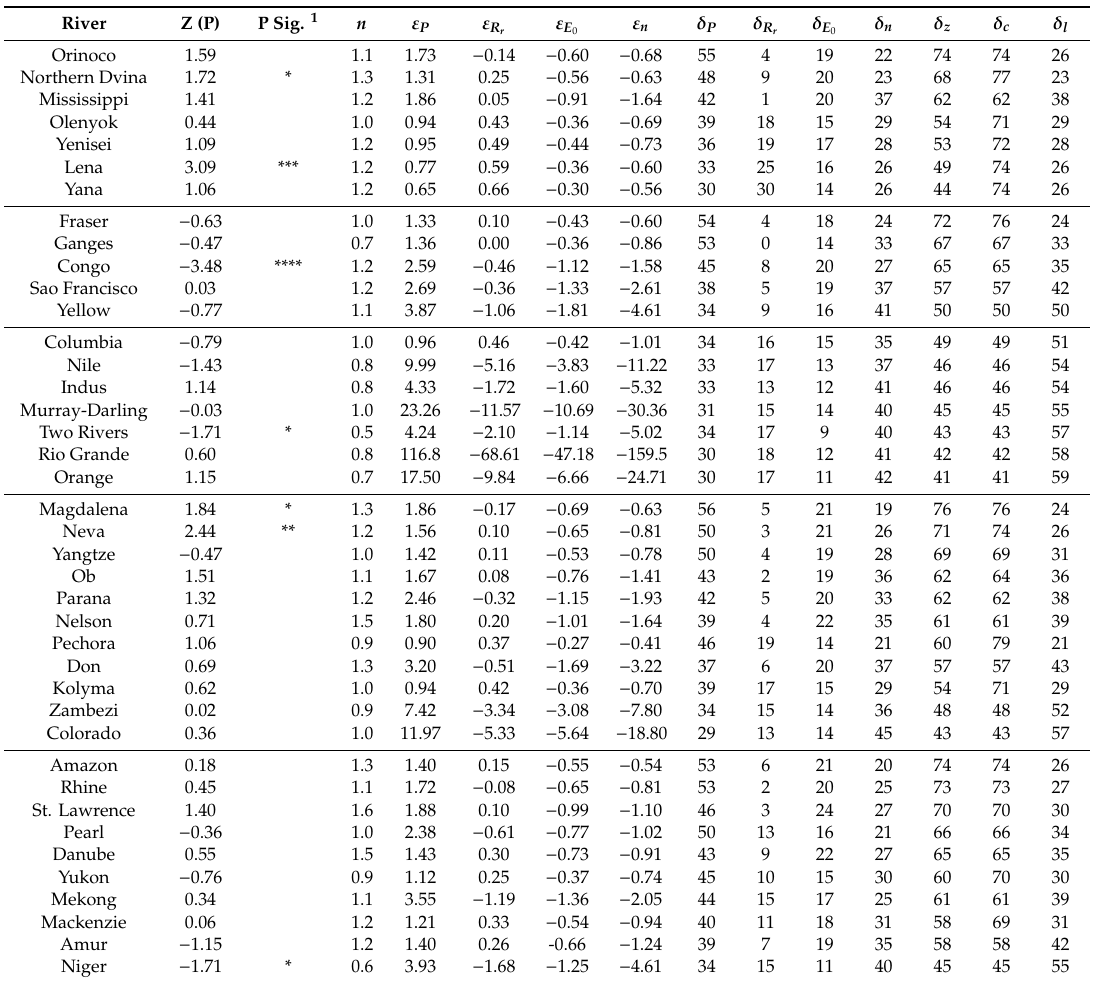
Table 4. Underlying surface coe ffi cient and elastic coe ffi cient and contribution rate of each influencing factor of each